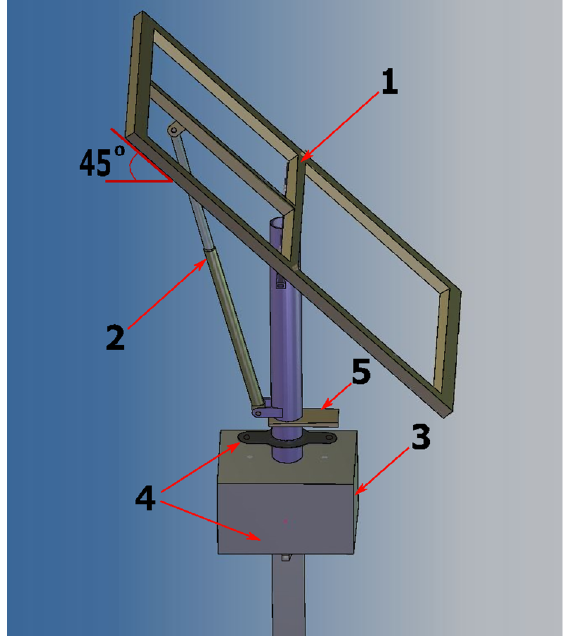
Figure 2. The general structure of a single-axis solar tracker.